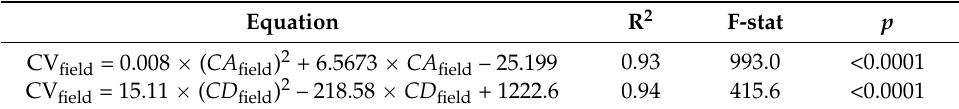
Table 3. Derived best-fit regression parameters for calculating canopy volume (CV field ) from Equation (1) using field measurements of crown projected area (CA field ) and crown diameter (CD field ). Multiplier value = 0.3927 ( n = 79).